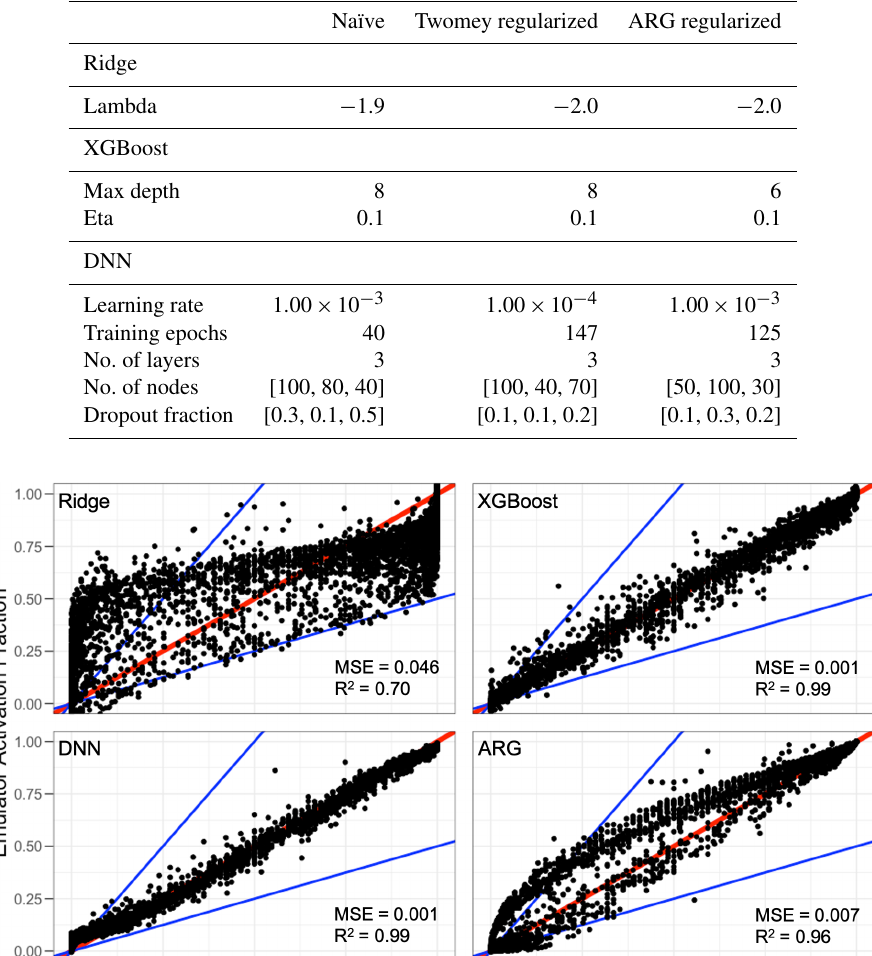
Table 2. Emulator hyperparameters chosen in this study.